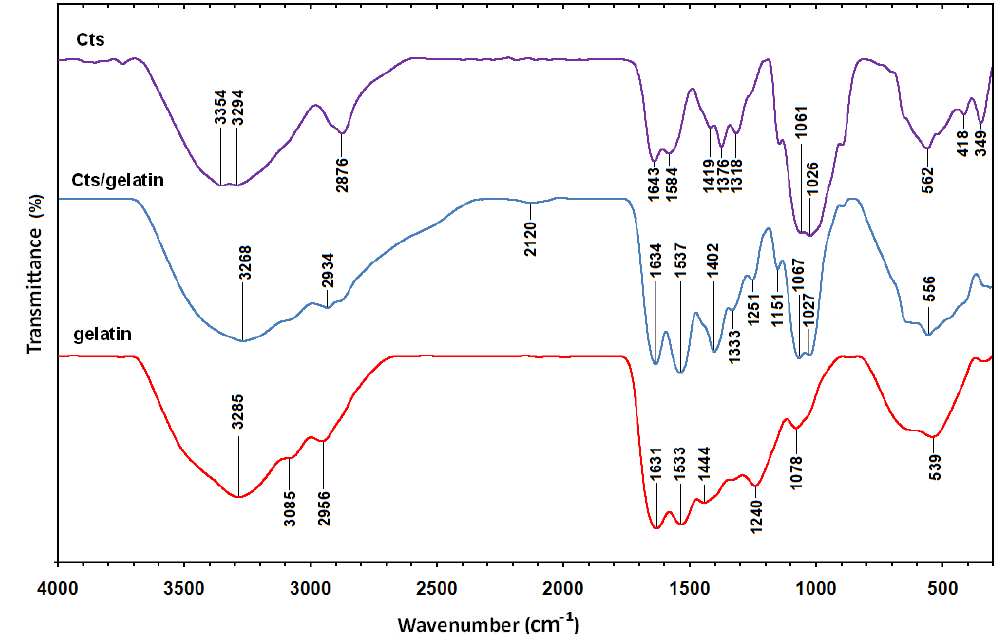
Figure 6. Fourier transform infrared spectra of Cts, Cts/gelatin, and